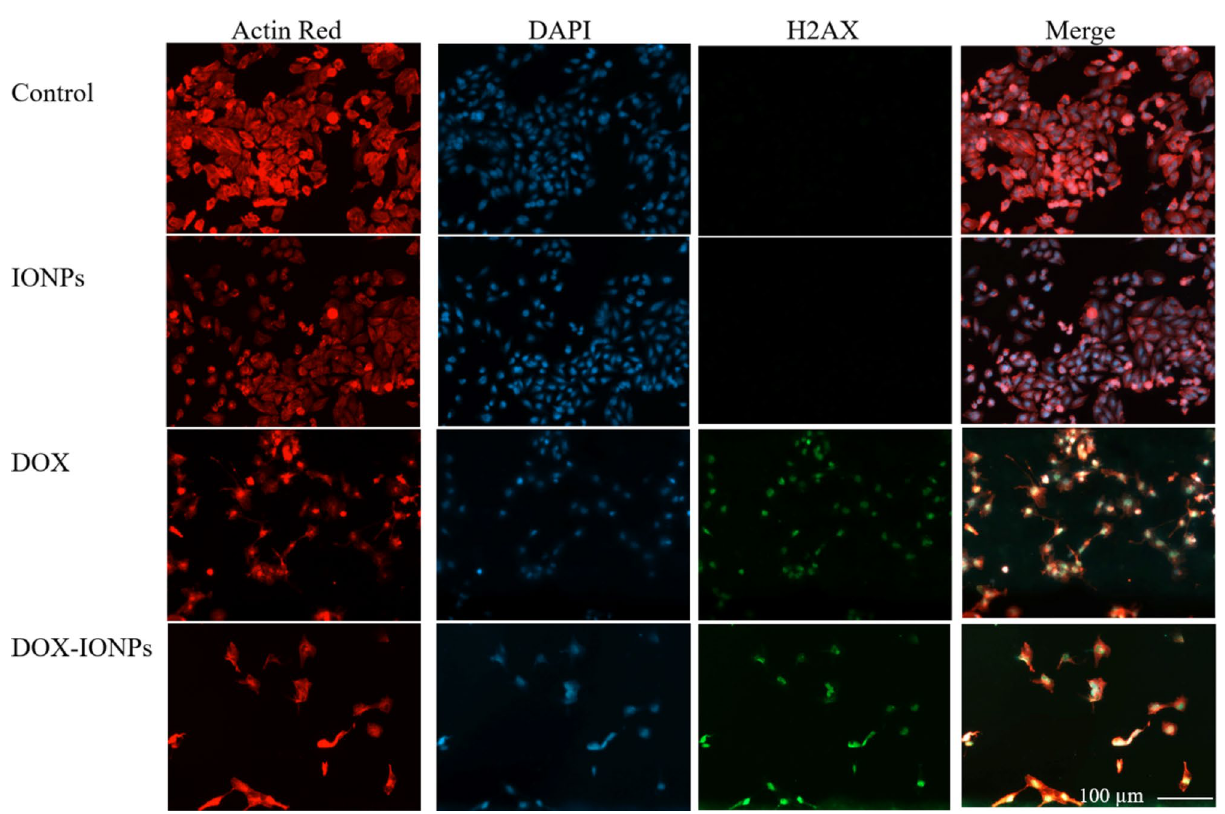
Figure 8. Fluorescence microscopy images of U251 with or without treatment after 48 h. Red, blue and green fluorescence colours represent Alexa Fluor@ 488 phalloidin-stained F-actin, DAPI-stained cell nuclei, and γ-H2AX, a marker of DNA double-strand breaks, respectively. IONPs and DOX-IONPs represent for EDT- IONPs and